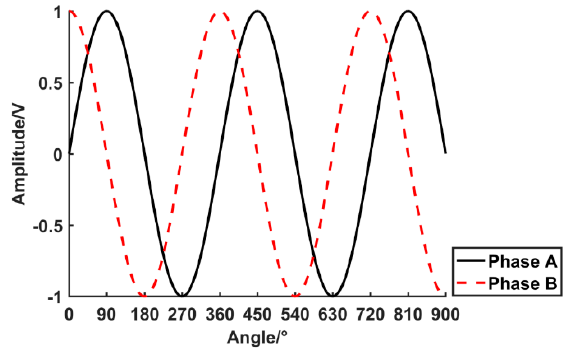
Figure 1. Voltage signals of phases A and B.